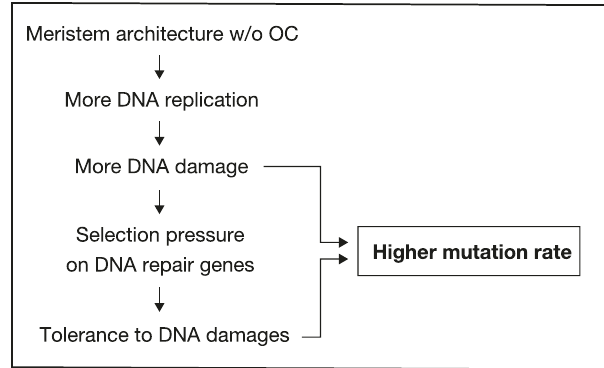
Fig. 6 Hypothetical scenario leading to higher mutation rates in Podostemoideae. In Podostemoideae, the meristem architecture was changed to one without the organising centre (OC). The change led to more DNA replication in the generation and more DNA damage, which could have caused higher mutation rates. Further, more DNA damage would result in more selection pressure on DNA repair genes, such that more DNA damages are tolerated. The tolerance to DNA damages again could lead to higher mutation rates through survival of the cells with DNA damage leading to mutations rather than cell